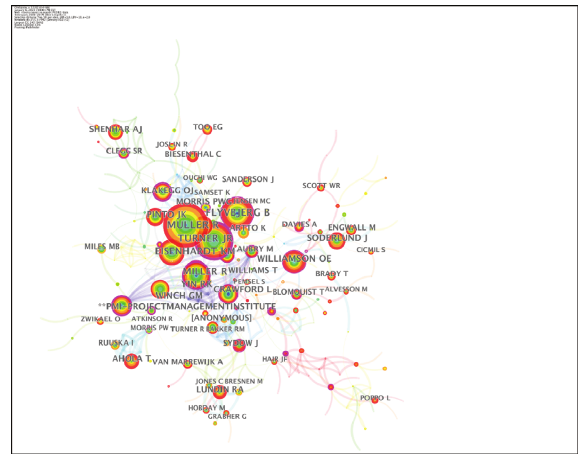
Figure 9: Network of author